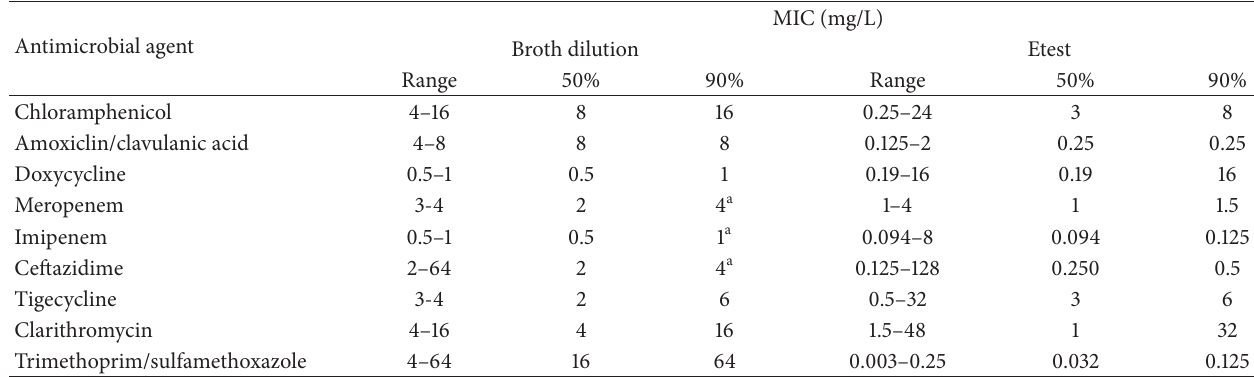
Table 3: Broth microdilution and Etest MICs of 81 B. pseudomallei isolates.